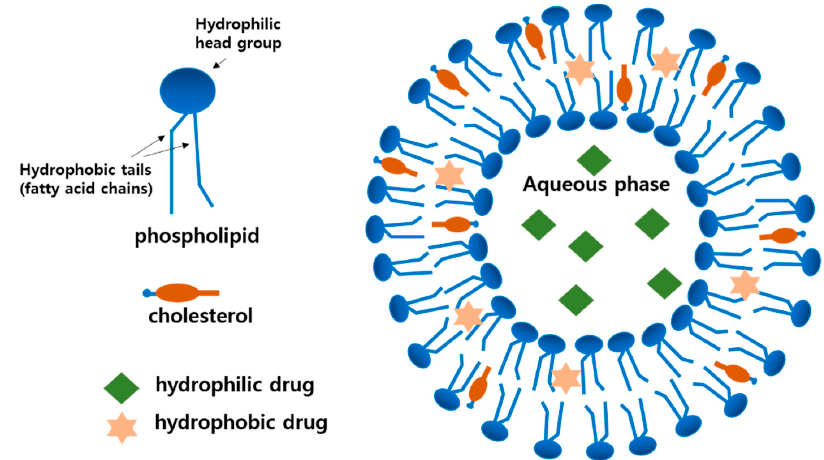
Figure 3. Structure of conventional liposome encapsulating hydrophilic and hydrophobic drugs .